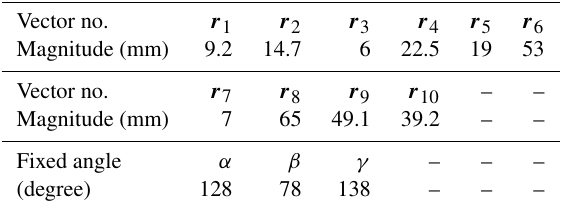
Table 1. Dimensional parameters. Vector